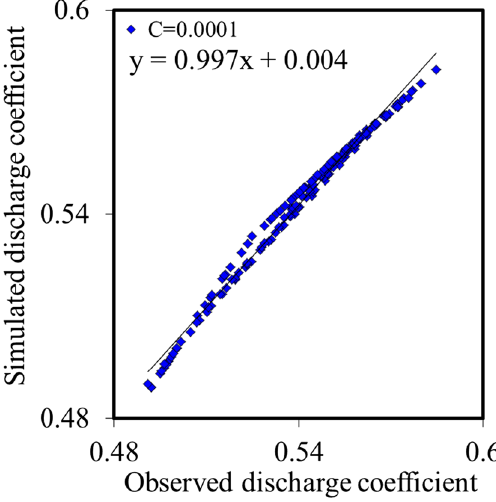
Fig. 10 Scatter plot for regularization parameter equal to